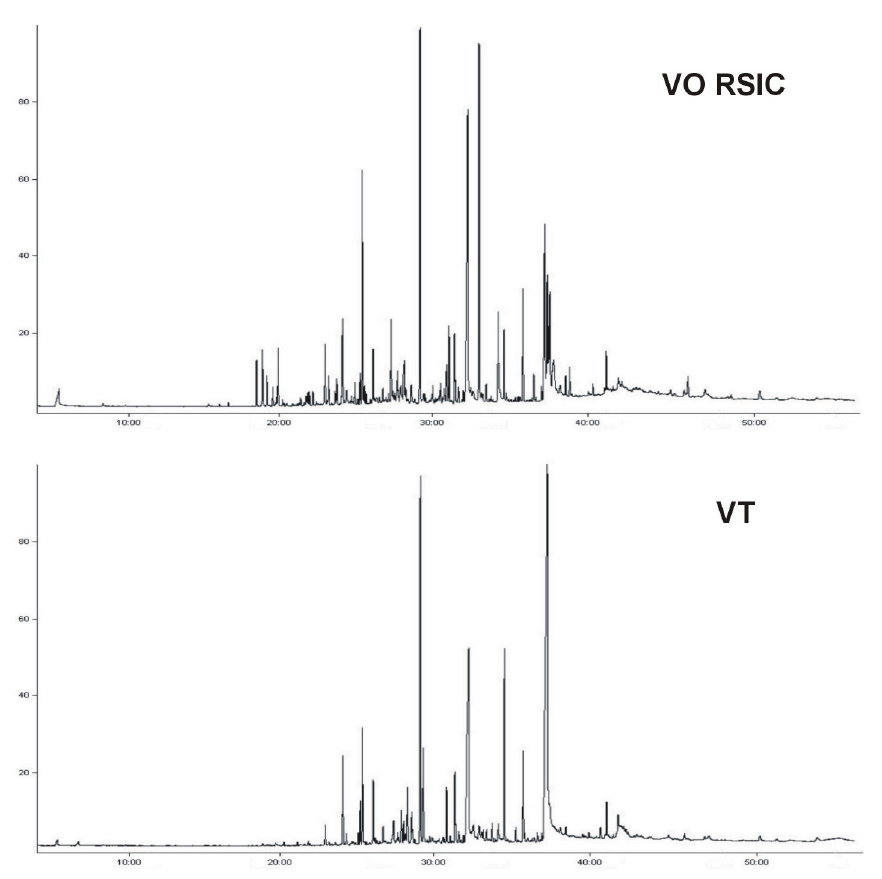
Figure 2: GC-MS chromatogram of VO RSIC and VT n -hexane